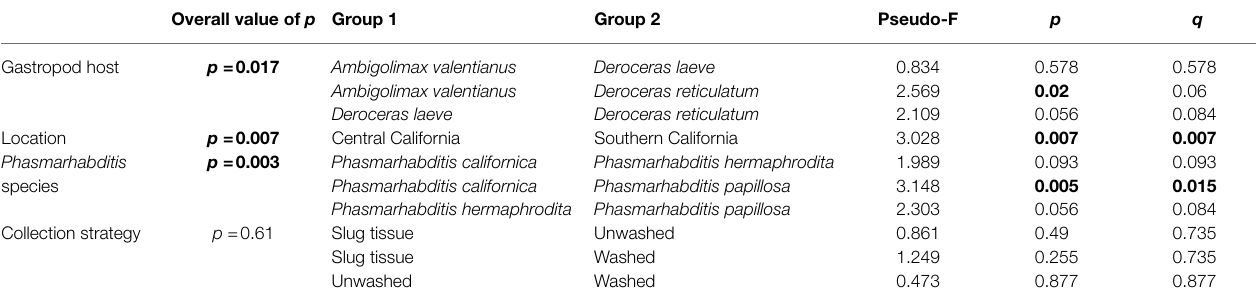
TABLE 1 | permANOVA analysis reveals the microbial differences between gastropod hosts, locations, Phasmarhabditis species, or washed/unwashed/slug tissue. Overall value of p Group 1